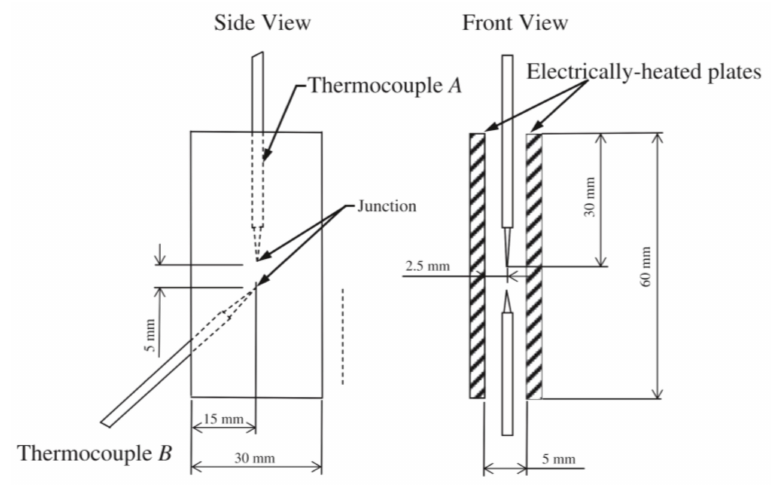
Figure 2. Positions of thermocouples A and